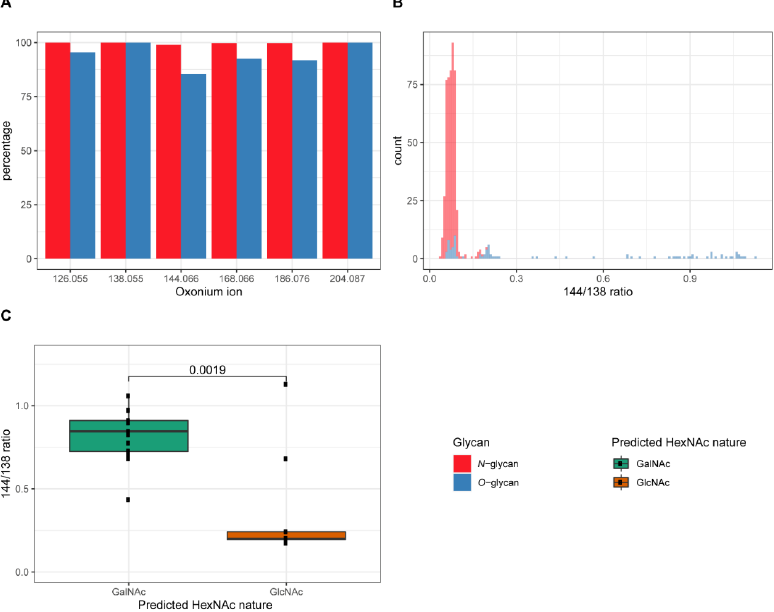
Figure 1. Discrimination of different glycopeptide populations. ( A ) Percentage ( y -axis) of assigned N - (red) and O -glycopeptides (blue) spectra (with Byonic score above 250) containing the oxonium ions ( x -axis). ( B ) Distribution of intensity ratio for oxonium ions at m / z 144.066 and 138.055 (=144/138) for N - and O -glycopeptides. The ratio was calculated when intensities from both oxonium ions were registered. ( C ) The box plot depicts the distribution of 144/138 ratios from unique O -glycopeptides based on their predicted single HexNAc nature (GalNAc versus GlcNAc). The HexNAc nature was predicted depending on the presence (for GalNAc, green) or absence (for GlcNAc, orange) of a transmembrane domain and/or a signal peptide. The prediction tools used were TMHMM Server v. 2.0, http://www.cbs.dtu.dk/services/TMHMM/ (accessed on 28 April 2021) and SignalP-5.0 Server, http://www.cbs.dtu.dk/services/SignalP/ (accessed on 28 April 2021), respectively. Data were statistically analyzed with Wilcoxon rank sum-test and p value is